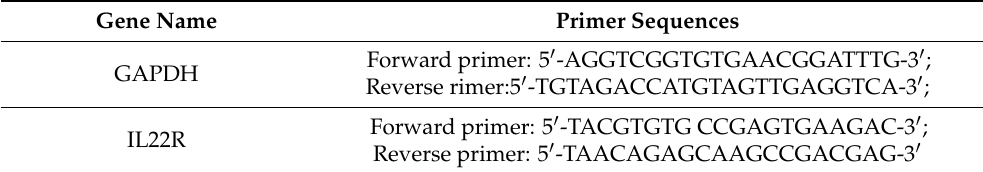
Table 1. Primer sequences used for